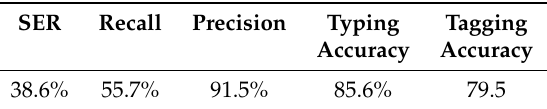
Table 3. The result